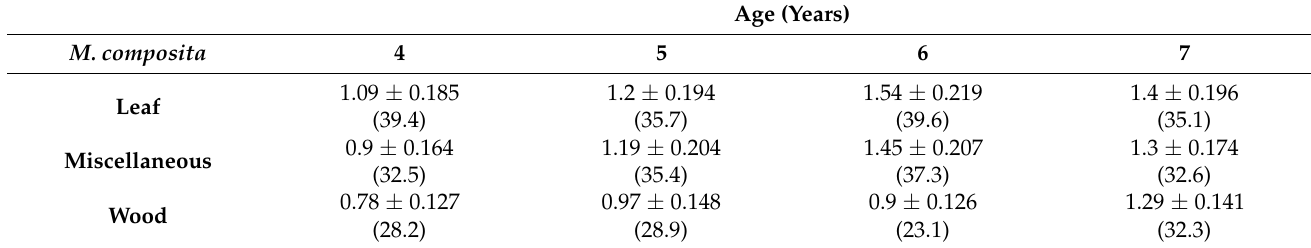
Table 7. Component-wise total litterfall (Mg ha − 1 ) mean ± SE of M. composita plantation of different ages: (a) 4 years old; (b) 5 years old; (c) 6 years old; (d) 7 years old. Value in parenthesis is the percent